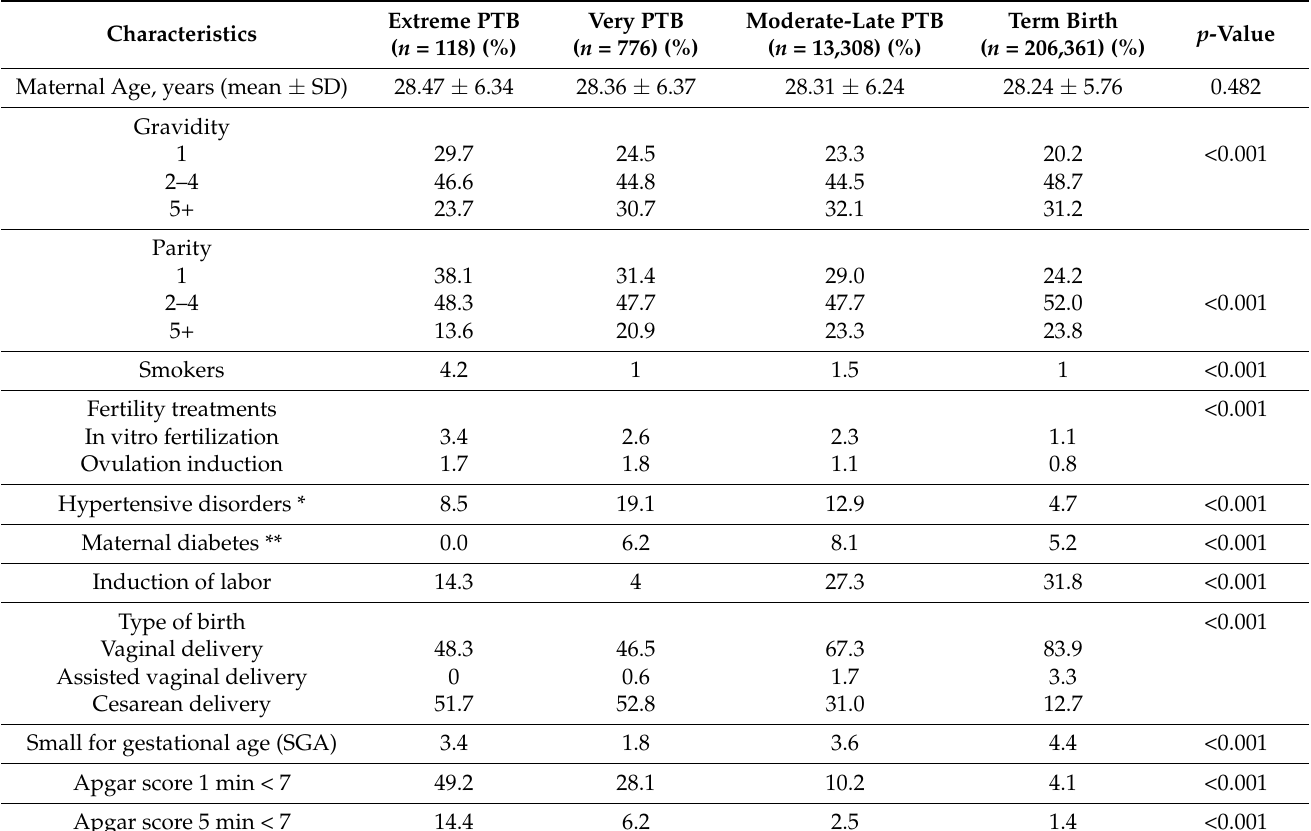
Table 1. Maternal characteristics and immediate perinatal outcomes of the study population according to gestational age at birth.